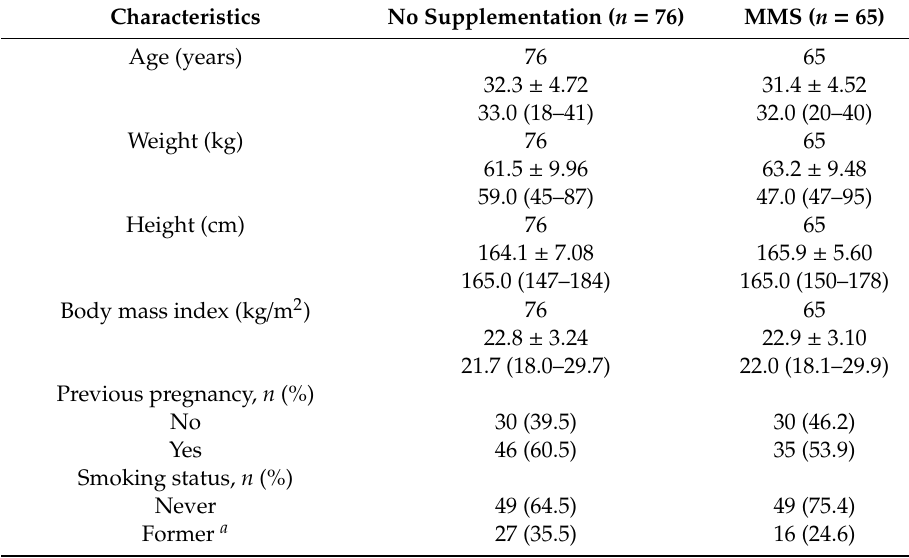
Figure 2. Flow diagram for study participants. DHA, docosahexaenoic acid; MMS, multiple micronutrients and DHA supplementation; RBC, red blood cells; PP, per protocol. Table 1. Subject characteristics at baseline (values expressed as n , mean ± standard deviation, and median (range), unless otherwise stated) and delivery information (values expressed as n (%), unless otherwise stated) (per protocol